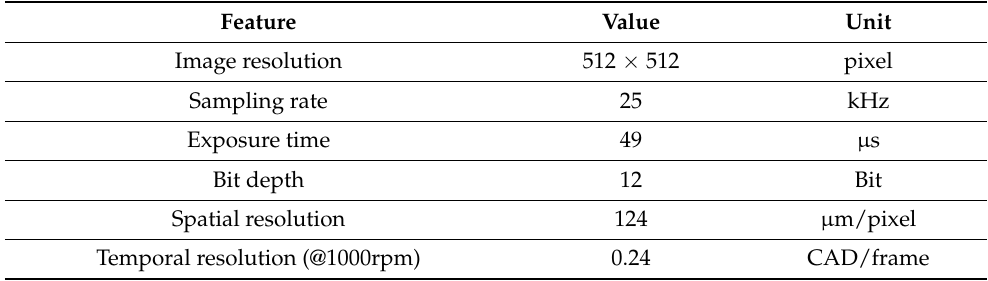
Figure 2. Area of the combustion chamber detected by the high-speed camera. Table 2. Optical access engine